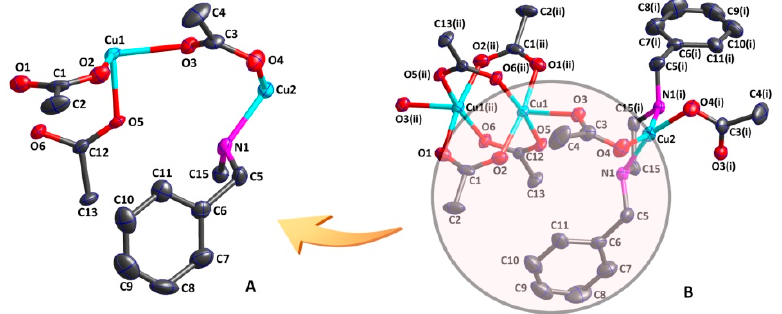
Figure 1. An asymmetric unit of compound ( 1 ) ( A ) and a secondary structure with a paddlewheel Cu 2 (CO 2 ) 4 unit ( B ) (thermal ellipsoids at 30% probability level). Symmetry codes: (i)1 − x,y,3/2 − z; (ii)1/2 − x,3/2 − y,1 − z.